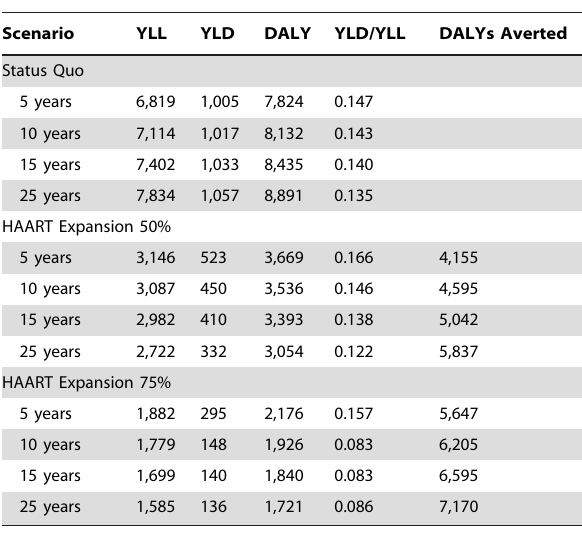
Table 2. Burden of Disease of Status Quo and 50% and 75% HAART expansion